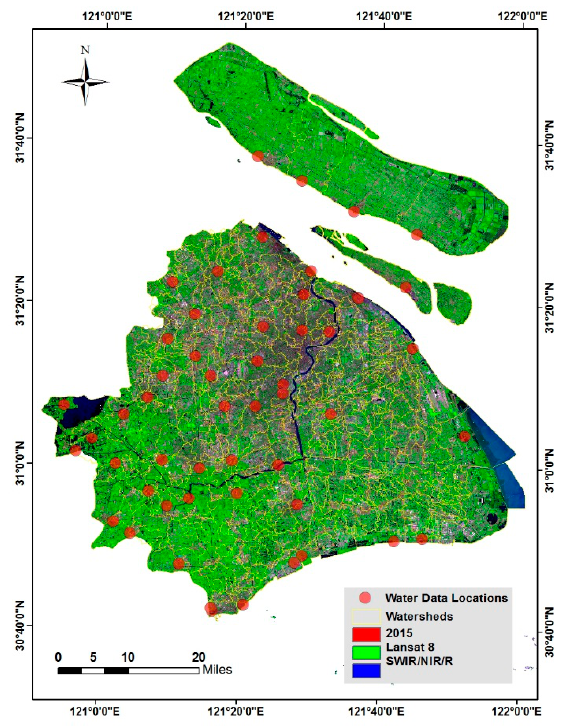
Figure 1. An example Landsat 8 OLI image (SWIR/NIR/R composition) of the study area. Water sample points and unit watersheds are overlaid in the